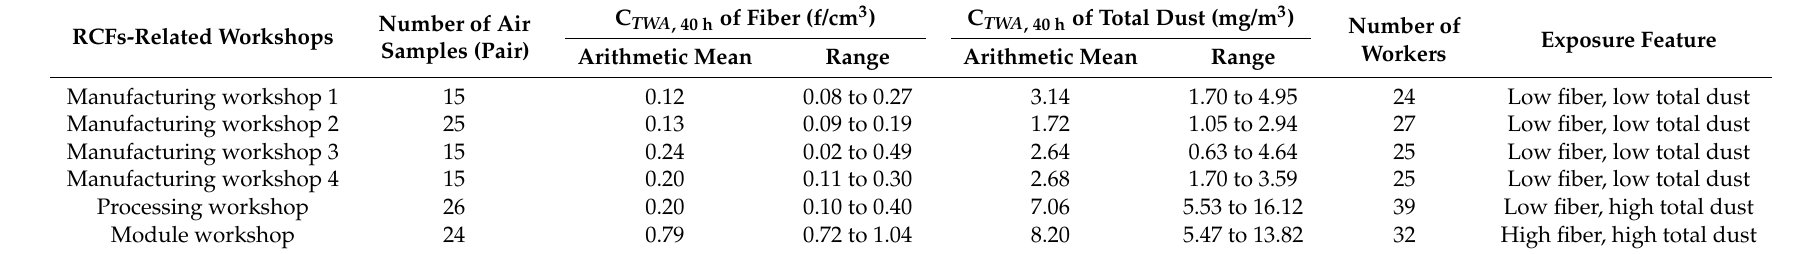
Table 1. Fiber and total dust concentration in different refractory ceramic fibers (RCFs)-related workshops.